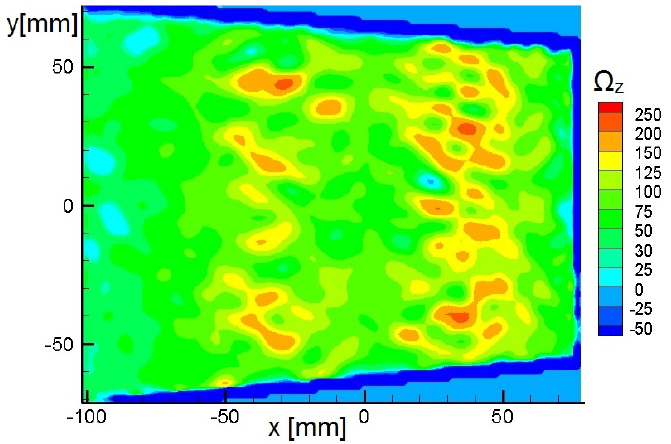
Figure 6. Average vorticity.